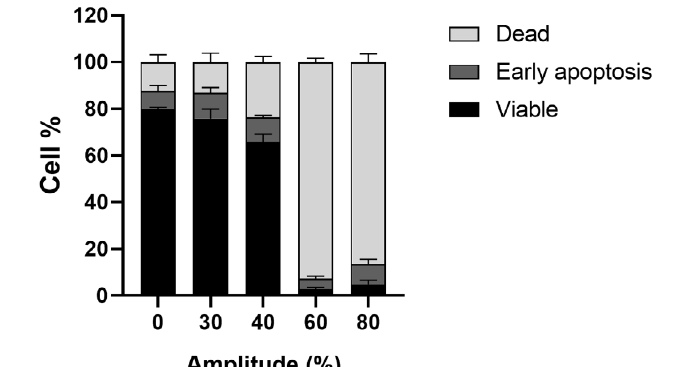
Figure 2. Viability of CT26 cells treated with short-thermal HIFU at various amplitudes for 10 s. 5 × 10 5 CT26 cells in 50 µL of cell culture medium were incubated at 37°C (0% Amplitude) or treated with short-thermal HIFU at various amplitudes (30% to 80%) for 10 s. Percentage of viable/dead/early apoptosis cells were calculated from Annexin V apoptosis assay 30 min after HIFU treatment. The results are presented as an average of 3 independent experiments (bar ±